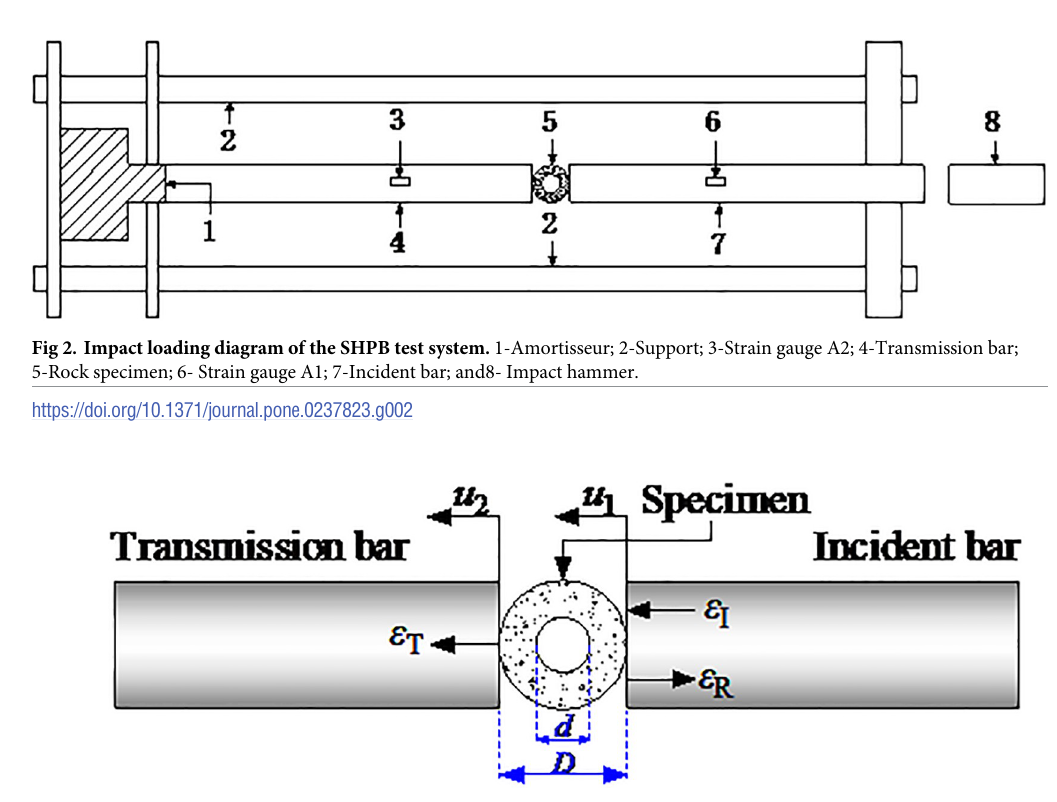
Fig 3. Schematic diagram of the stress deformation of circular granite under radial impact